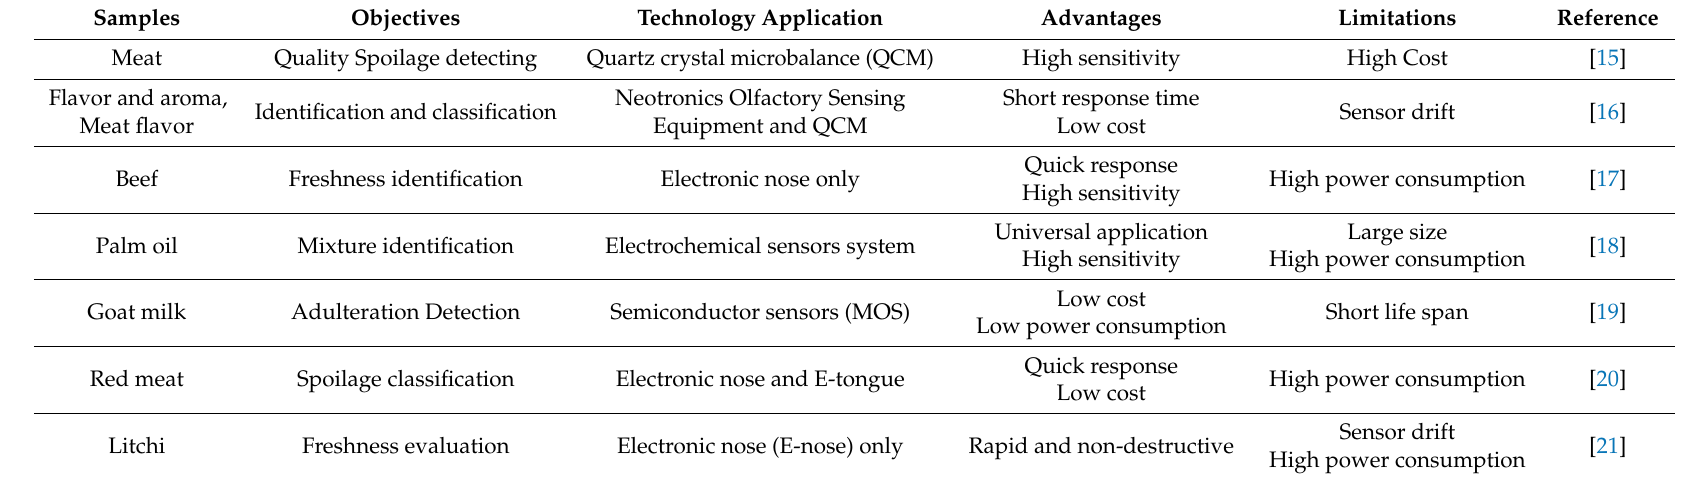
Table 1. The advantages and limitations of e-noses application on food